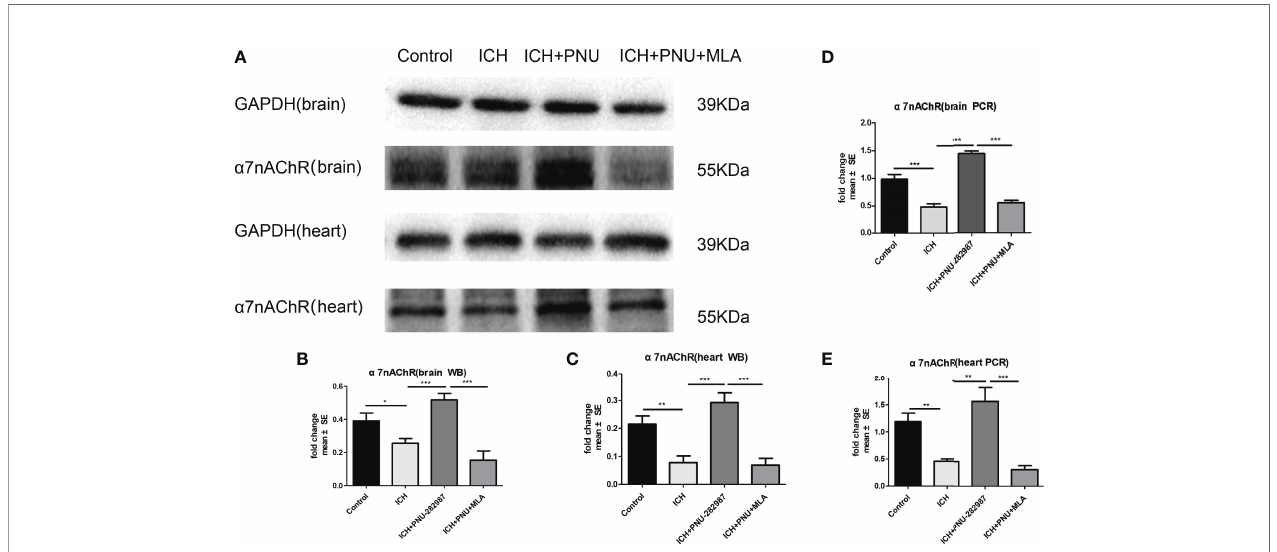
FIGURE 6 | The expression of a 7nAChR was reduced in brain and heart After ICH. (A) Representative protein expression levels of a 7nAChR in brain and heart, the expression of protein a 7nAChR remarkably reduced at 7 days after ICH, while PNU-282987 promoted their expression. (B) Quanti fi cation of western blot data in brain. (C) Quanti fi cation of western blot data in heart. (D) ICH for 7 days signi fi cantly decreased mRNA expression of a 7nAChR in brain, PNU-282987 promoted their expression. (E) ICH for 7 days signi fi cantly decreased mRNA expression of a 7nAChR in heart, PNU-282987 promoted their expression. n= 6 per group. Data are presented as mean ± SE; *p < 0.05; **P < 0.01; ***P <